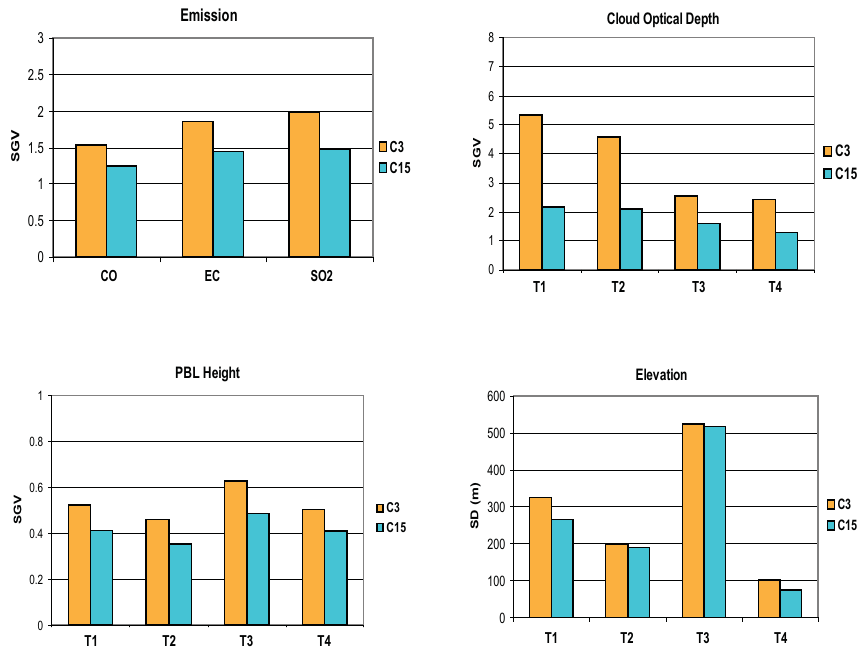
Fig. 15. The SGV in C3 and C15 simulations for surface emission (CO, EC and SO 2 ) , cloud optical depth, and PBL height, and SD for elevation. The SGV and SD are calculated over the time period 5–30 March